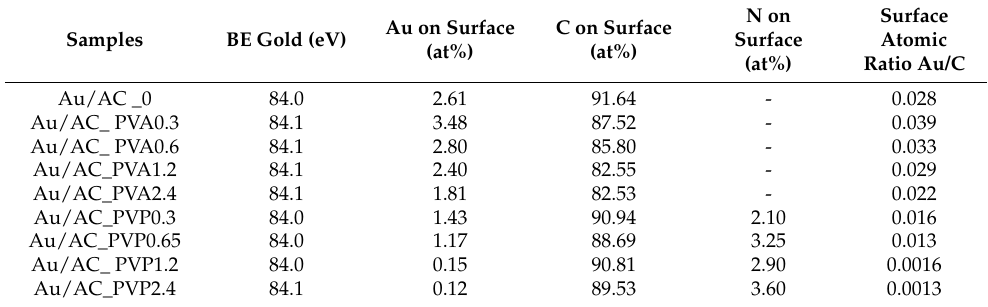
Table 2. XPS data for supported Au nanoparticles using PVA and PVP with different polymer to Au weight